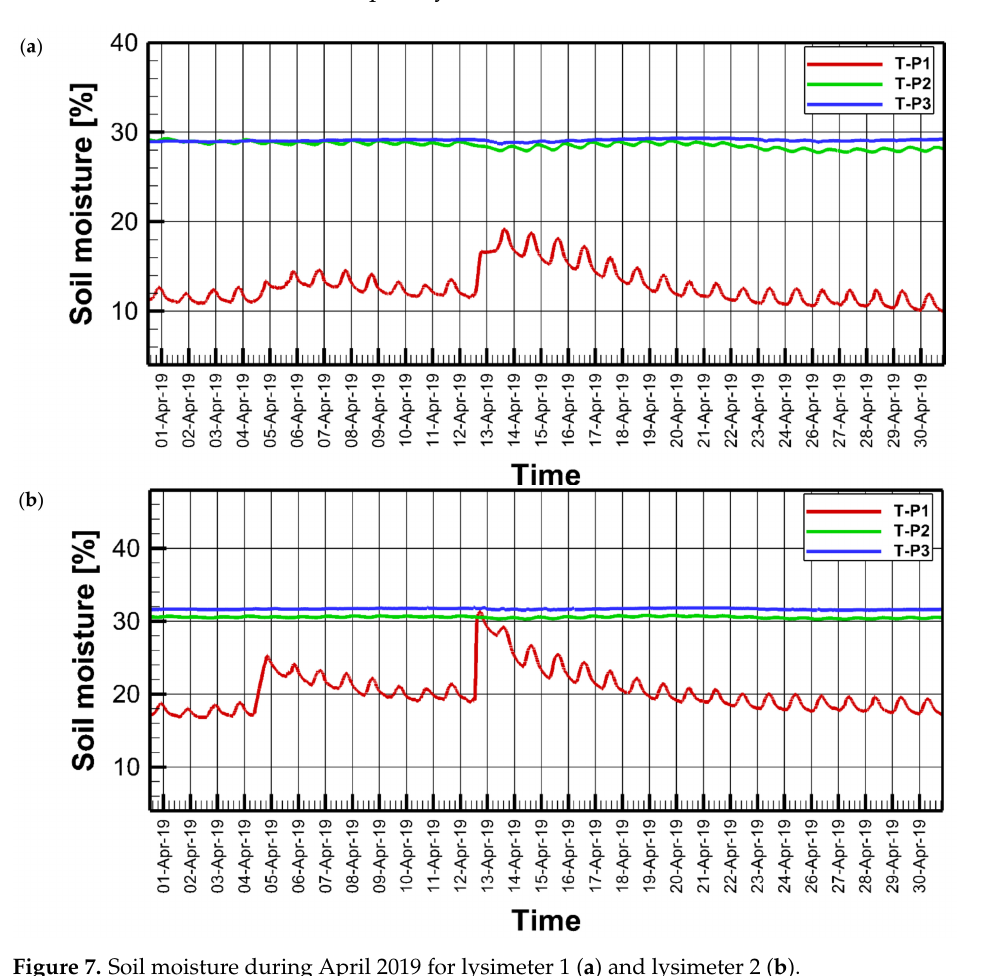
Figure 7. Soil moisture during April 2019 for lysimeter 1 ( a ) and lysimeter 2 ( b